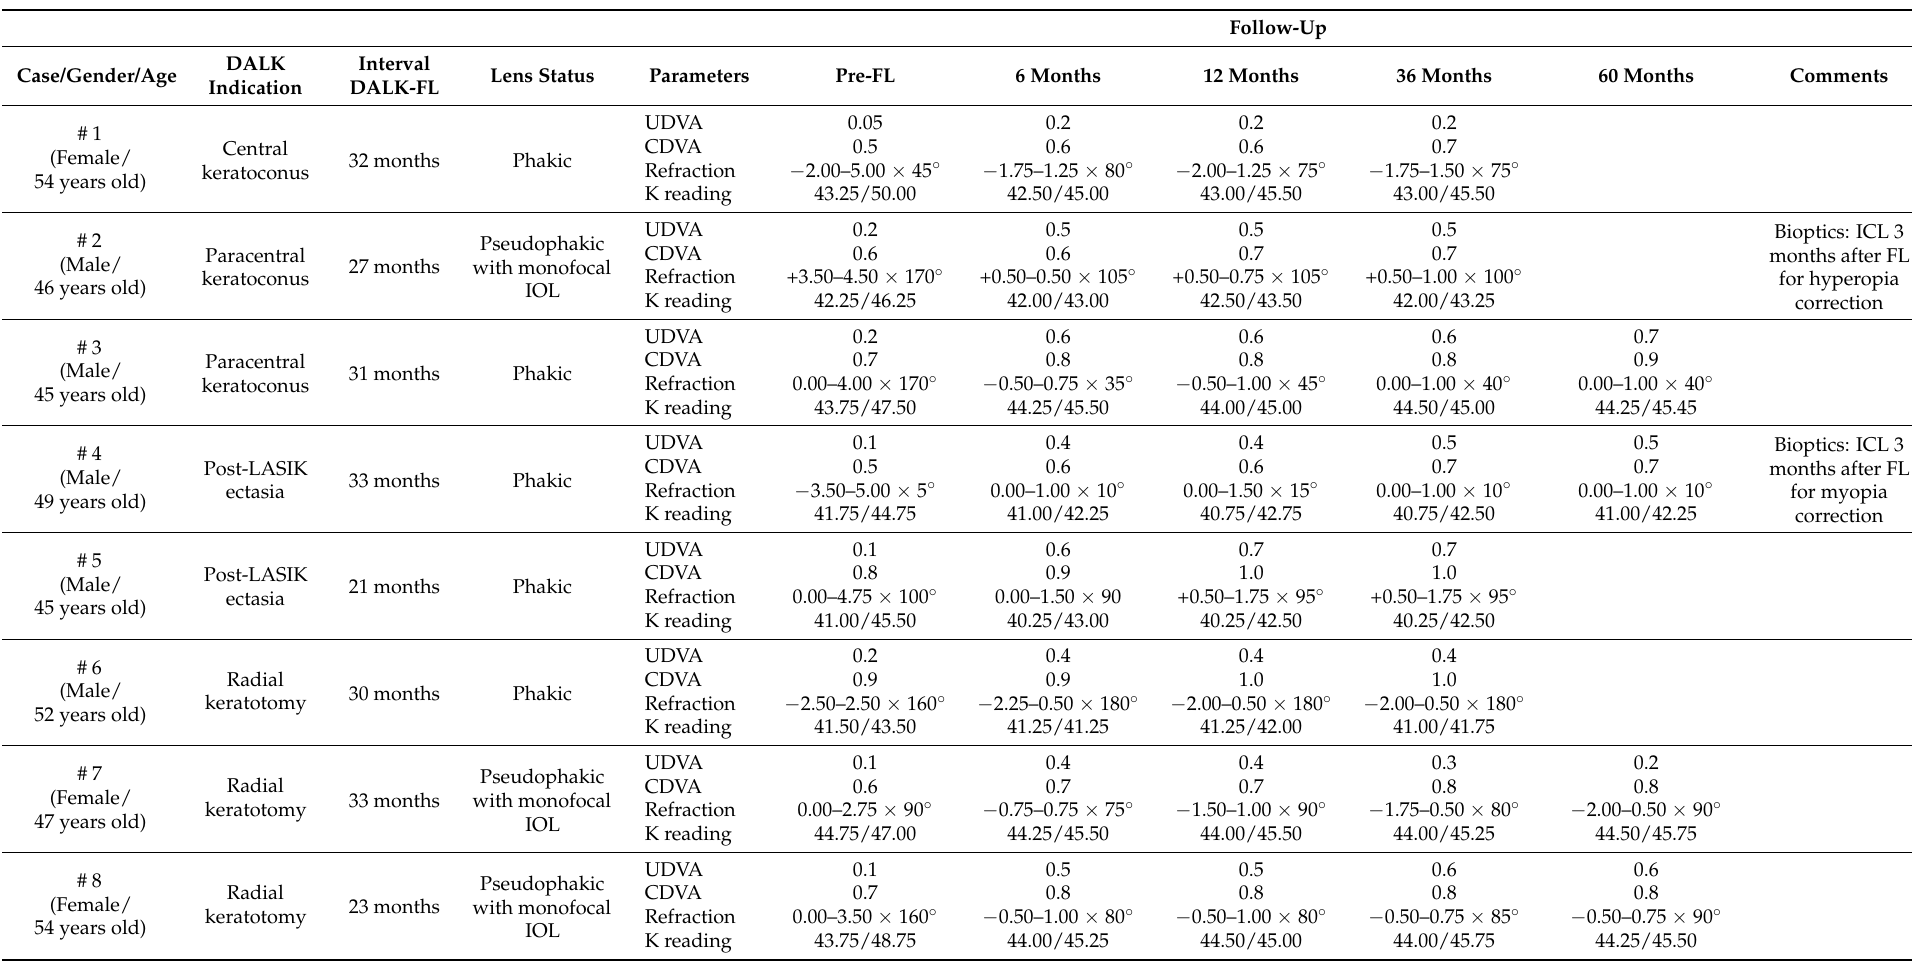
Table 1. Uncorrected (UDVA) and best-corrected visual acuity (CDVA) (expressed in decimal value) and refractive error before and after Femto-LASIK for each